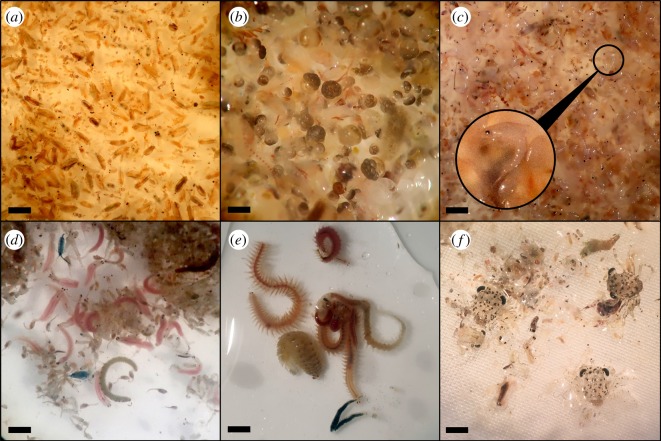
Photographs of representative pelagic (a–c) and emergent (d–f) zooplankton samples collected at D'Arros Island, Seychelles. Pelagic samples were collected during daylight hours using a towed plankton net and were dominated by copepods (a), fish eggs (b) and crab zoea (c). Emergent samples were collected using a light trap deployed after sunset for 2.5 h and were dominated by polychaetes and ostracods (d), polychaete worms (e) and crab megalopae (f). Scale bar (approx. sizes; a–f): 1, 0.5, 1, 2, 2, 2 mm.